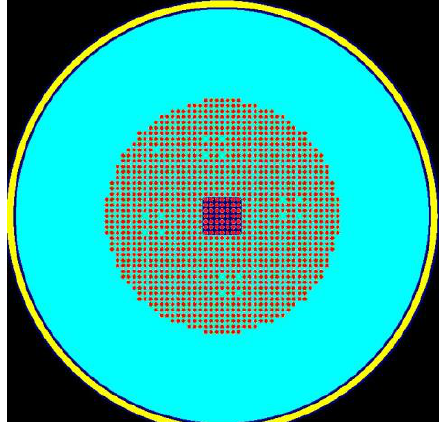
Figure 1. : Radial cross-section of the UH1.2 EPICURE configuration (“as-built” TRIPOLI4 model